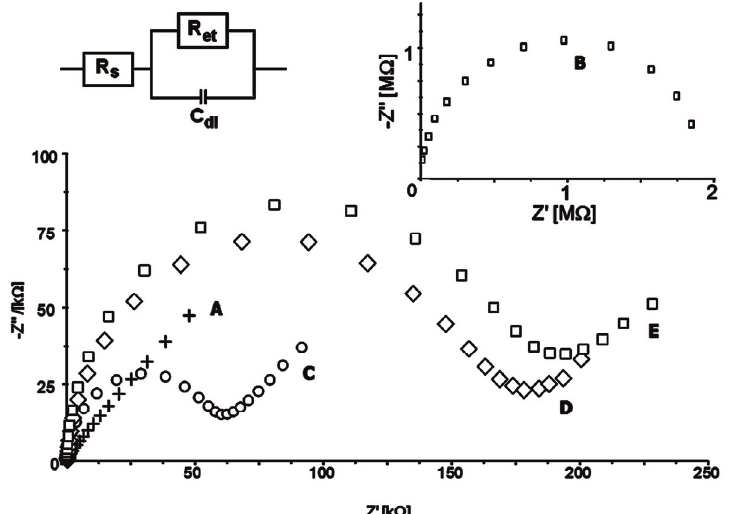
Figure 4. Impedance spectra of (A) clean gold electrode surface; (B) 1,6-hexanedithiol/ Au electrode; (C) gold nanorods/1,6-hexanedithiol/Au electrode; (D) F(ab’)/gold nanorods/ 1,6-hexanedithiol/Au electrode; (E) bovine serum albumin/F(ab’)/gold